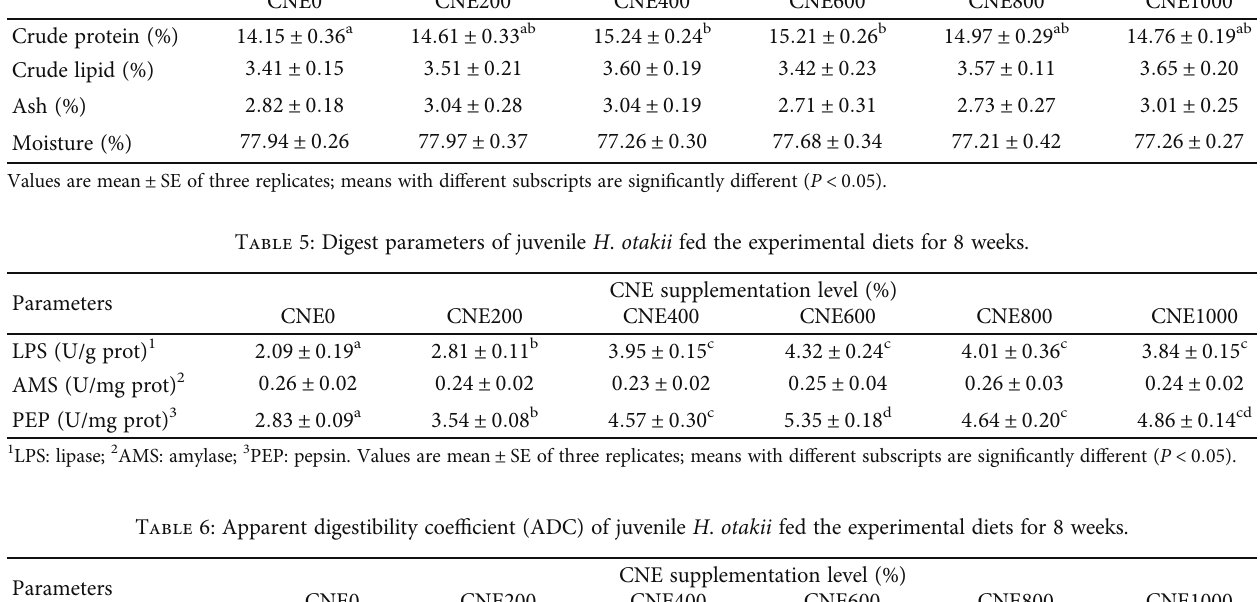
Table 4: Muscle composition (g/kg in dry matter) of juvenile H . otakii fed the experimental diets for 8 weeks. Parameters